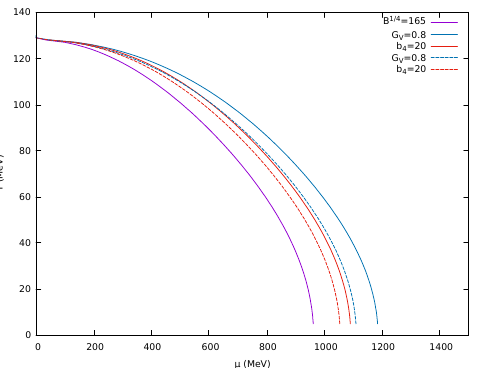
Figure 23. Phase diagram for neutral matter in β -equilibrium with a temperature dependent bag pressure B ( T ) . Dashed lines stand for X v = 0.4 and solid lines for X v = 1.0. Figure based on the results presented in